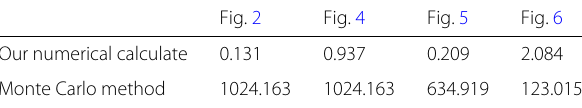
Table 1 Operation time(s) of our numerical calculate and Monte Carlo method Fig. 2 Fig. 4 Fig. 5 Fig.